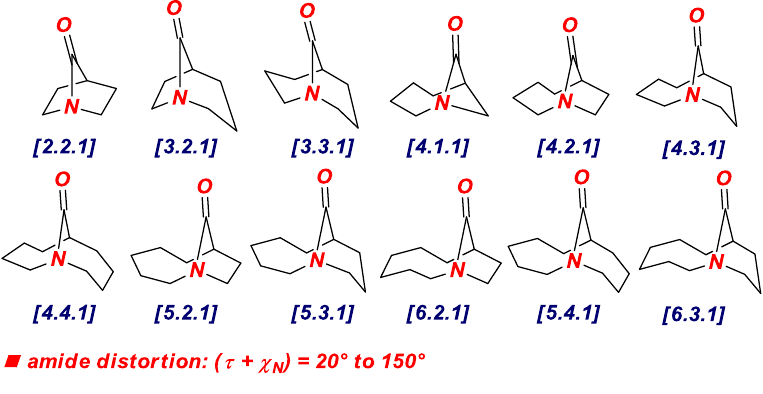
Figure 3. Additive Winkler-Dunitz Distortion Parameter: Sum of Twist Angle and Nitrogen Pyramidalization ( Σ τ + χ N ).